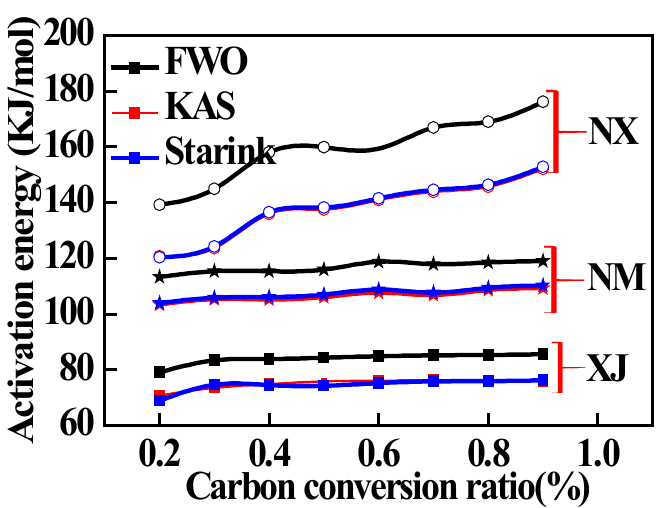
Figure 4. Activation energy E a values obtained using the FWO, KAS, and Starink methods as a function of X from the TGA results of the char samples derived from the NX, XJ, and NM coal sources (i.e., NX char, XJ char, and NM char).